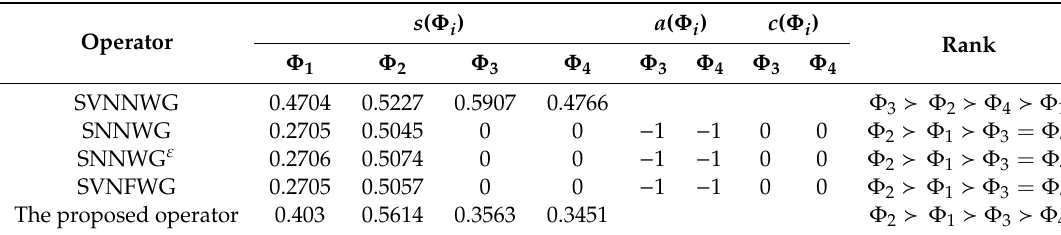
Table 4. Comparison